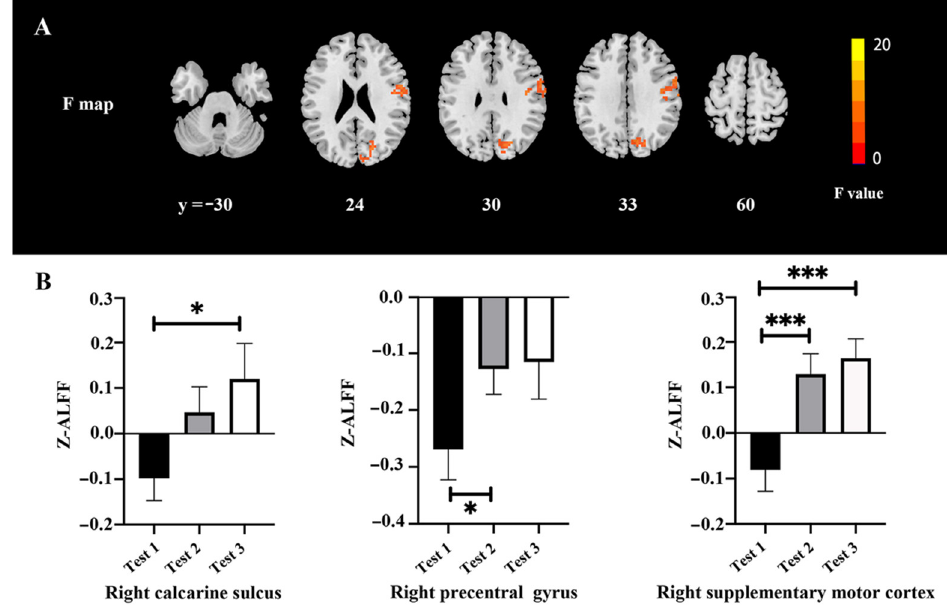
Figure 1. ALFF changes among the three time points: ( A ) Difference of ALFF maps among the three time points; ( B ) extracted clusters of significant ALFF alteration in three time points. * p < 0.05 and *** p < 0.001.